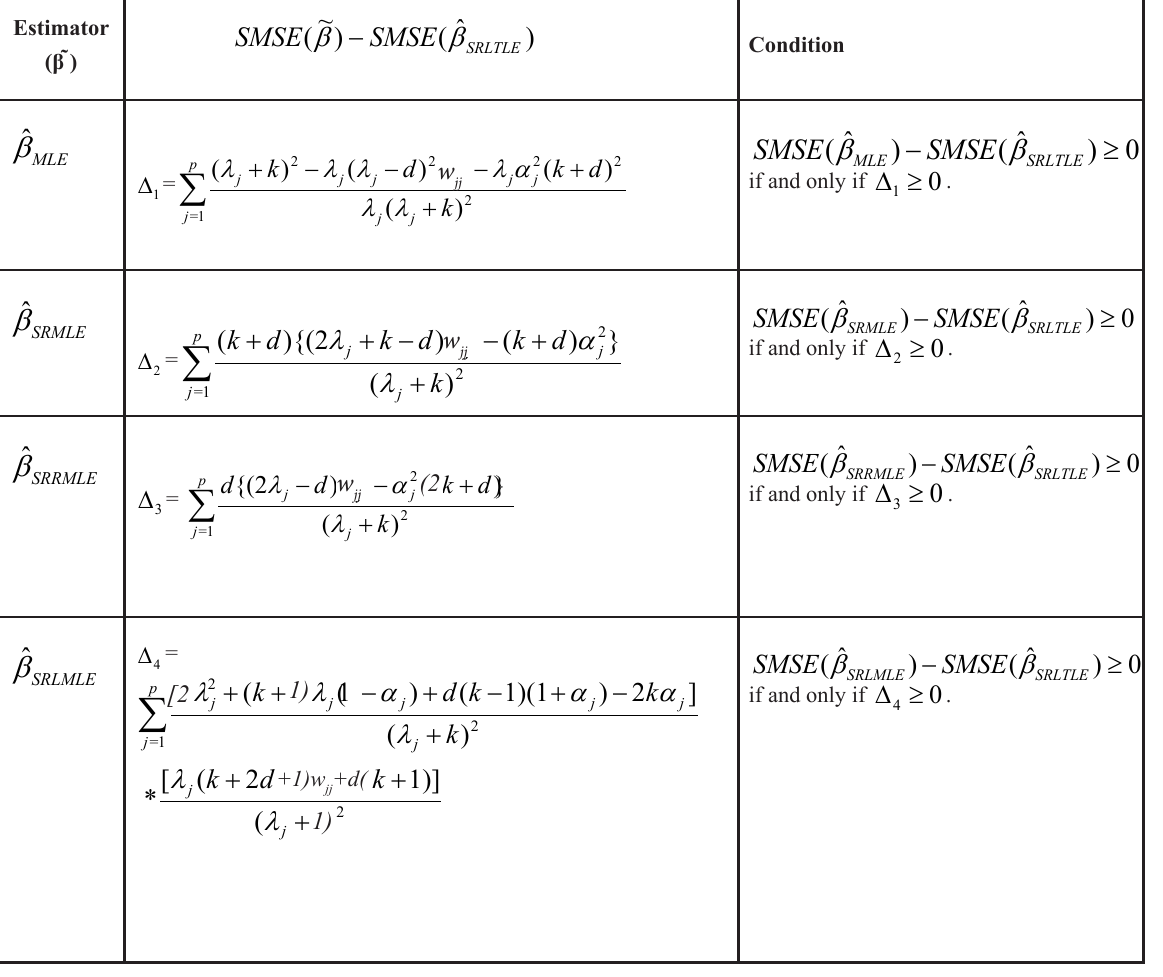
Table 4.1: Comparison of SRLTLE with other estimators.